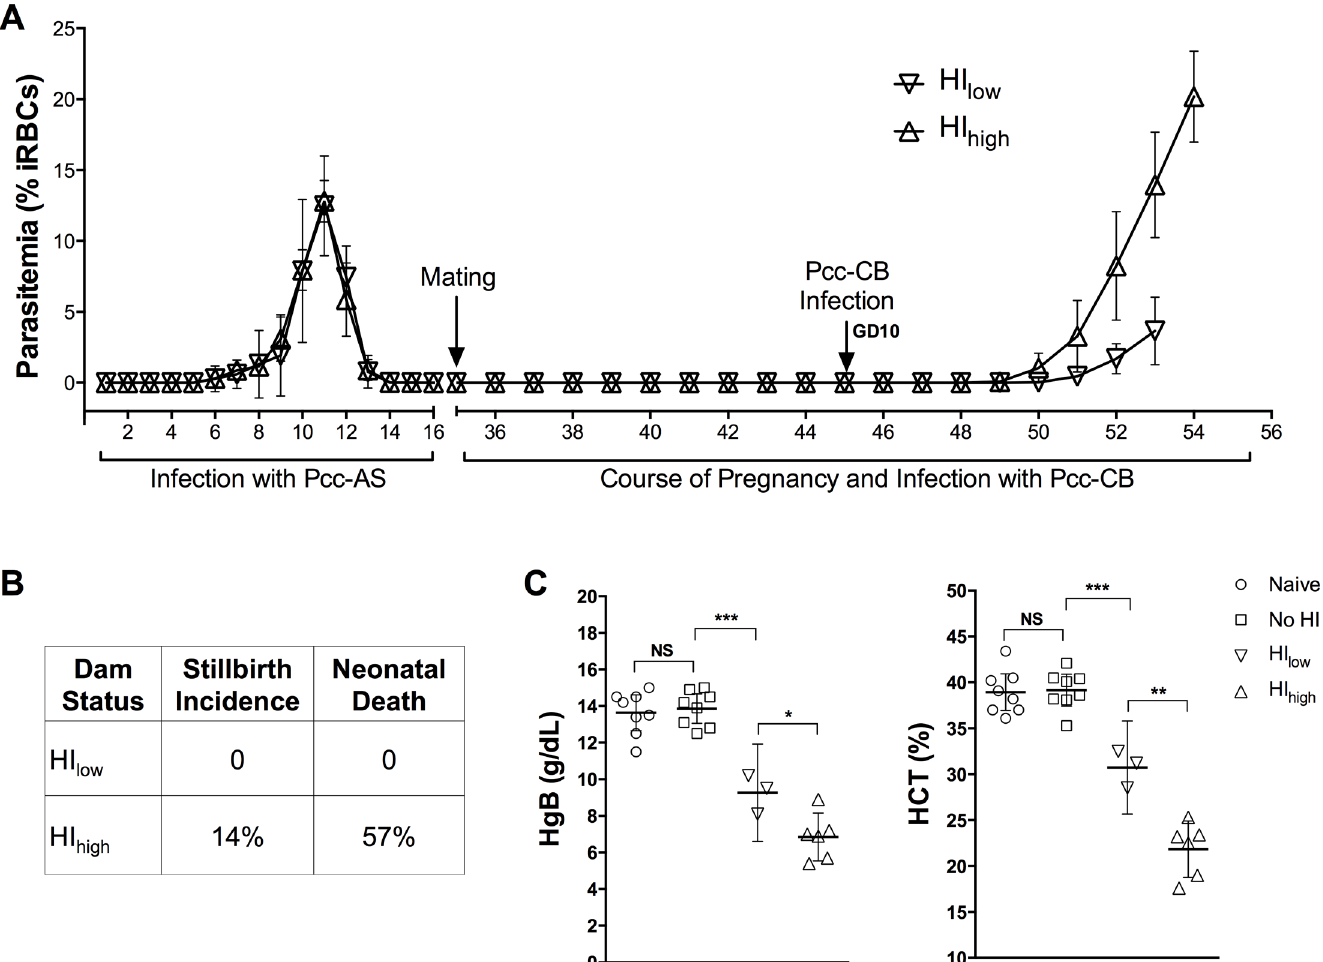
Fig 2. Course of HI in pregnant mice. After a primary infection initiated by inoculation of Pcc- AS sporozoites, mice were paired with males 35 days post- inoculation, then randomly assigned to be inoculated ( “ HI Pregnant ” , n = 12) or not inoculated ( “ No HI Pregnant ” , n = 8) with Pcc- CB iRBCs at gestational day 10. Control mice ( “ Na ï ve Pregnant ” , n = 8) were never inoculated with parasites, but were paired with males simultaneously with the infected mice. (A) Parasitemia was monitored during Pcc- AS sporozoite-induced infection and Pcc- CB iRBC-induced re-infection during pregnancy by daily blood smears. Data are presented as means with 95% confidence intervals. (B) Comparison of Hgb and HCT in different groups of mice as indicated at gestational day 18. Data are presented as means with 95% confidence intervals. Data were analyzed by one-way ANOVA using Bonferroni test to correct for multiple comparisons. * P < 0.01, ** P < 0.001, *** P < 0.0001, and NS = not significant. Similar results were obtained in two repeats of this